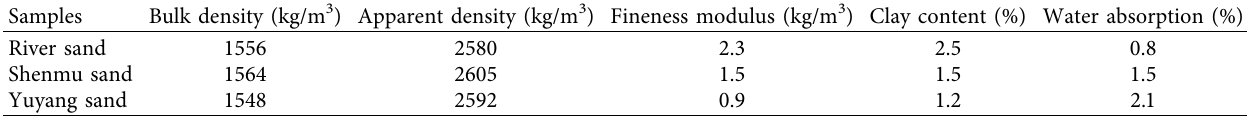
Table 1: Physical properties of used sand.